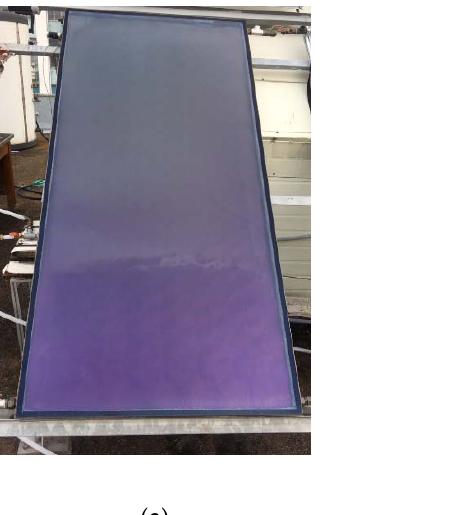
Figure 2. Schematics of the solar collector system.